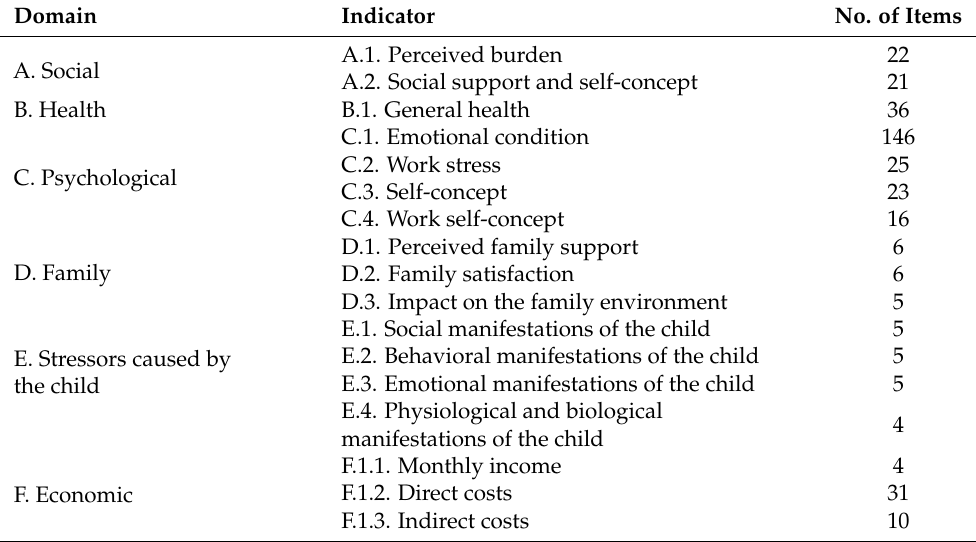
Table 2. Structure of